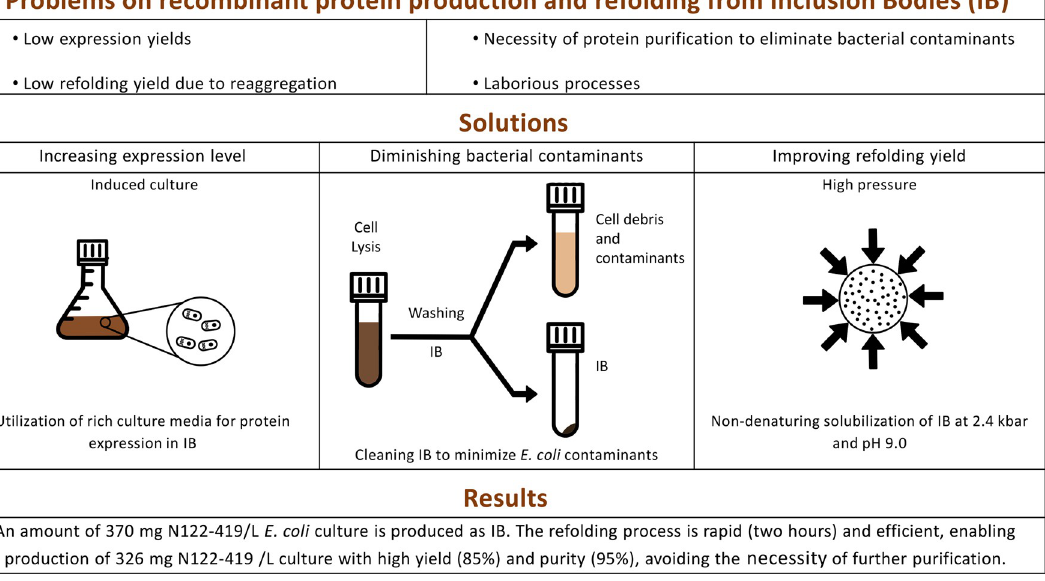
Fig 6. Scheme depicting the benefits of the utilization of the processes described in our study for expression of recombinant proteins, for washing inclusion bodies and for refolding.